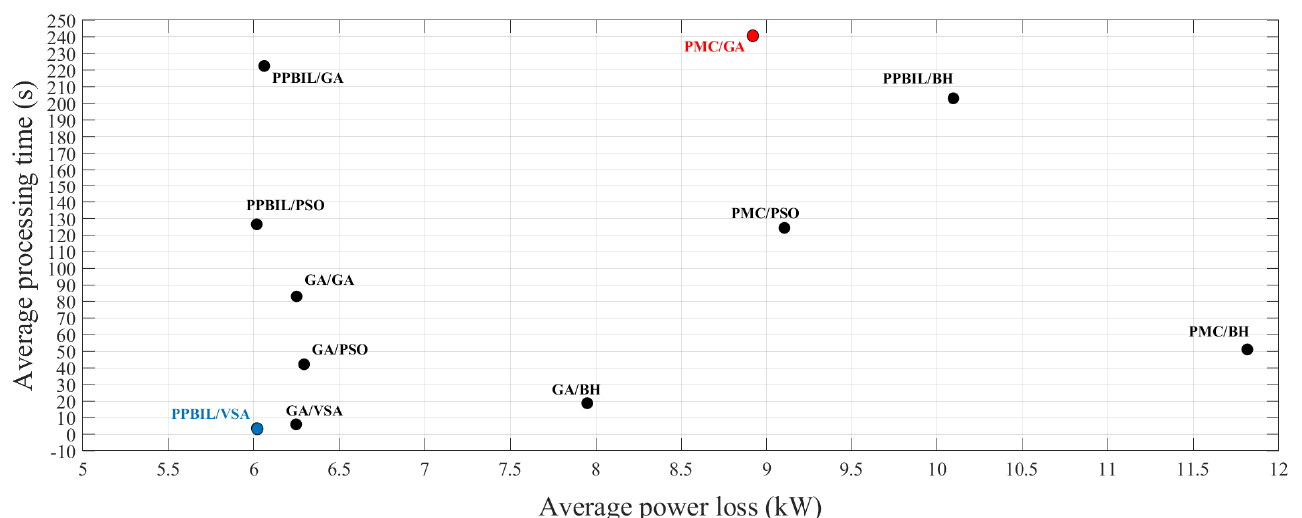
Figure 7. Trade-off between average power losses and required processing time provided by the hybrid methodologies in the 21-bus test system.